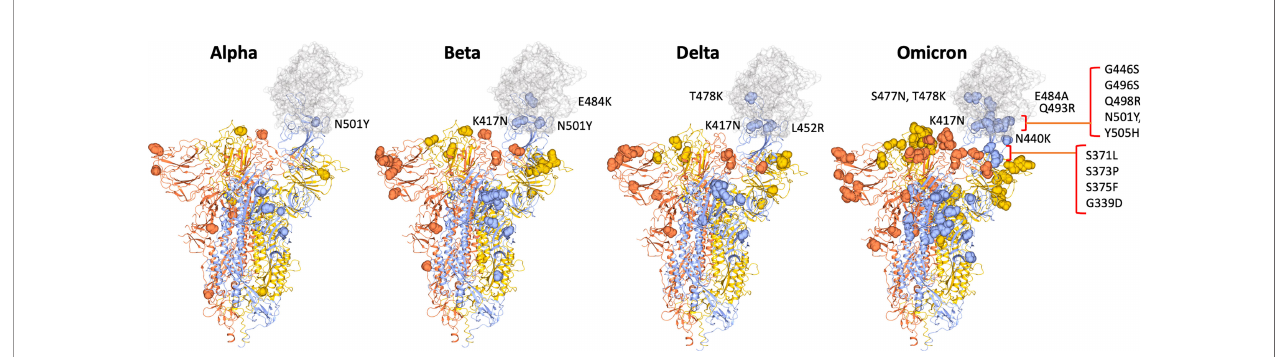
FIGURE 1 | SARS-CoV2 spike trimer showing two RBDs in the closed conformation and one in the open conformation bound to ACE2 (grey) (PDB: 7DF4) (28). The position of changes in spike of the Alpha VOC through to Beta, Delta and fi nally the Omicron VOC are shown as yellow or orange spheres in the two spike monomers with closed RBDs and as blue spheres in spike monomer with open RBD, highlighting the proximity of mutations in relation to the binding site with ACE2. Mutations in RBD are